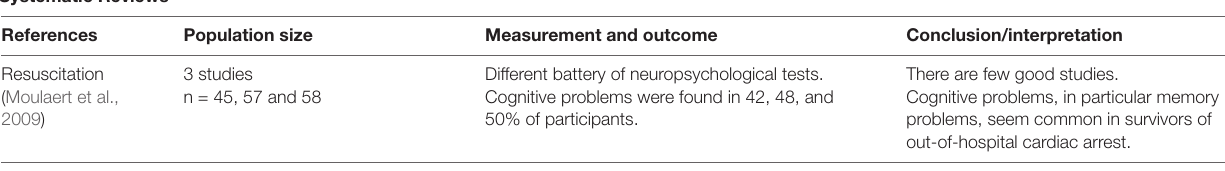
TABLE 1 | Excerpts from relevant studies according to level of